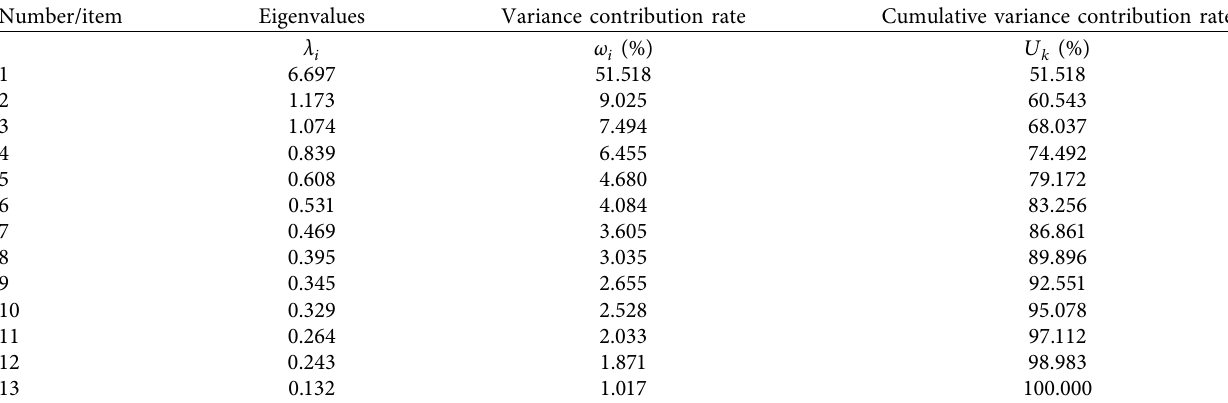
Table 3: Characteristic values and contribution rates of principal